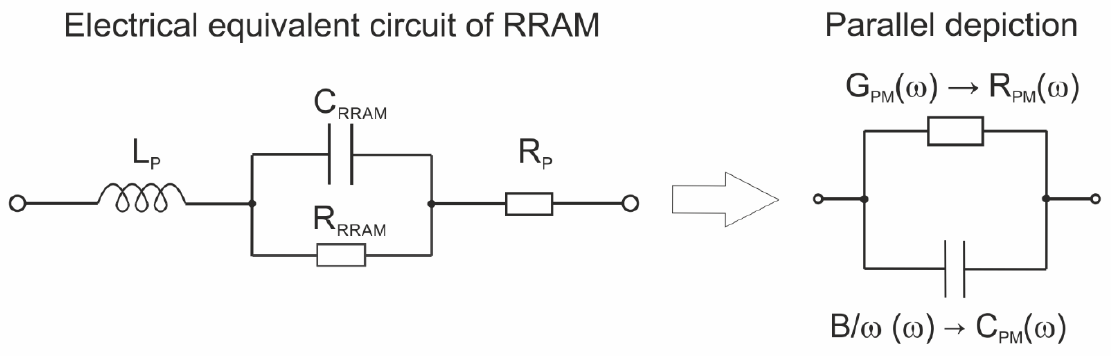
Figure 7. Electrical equivalent circuit of RRAM device with series parasitic components and its measurement parallel depiction.